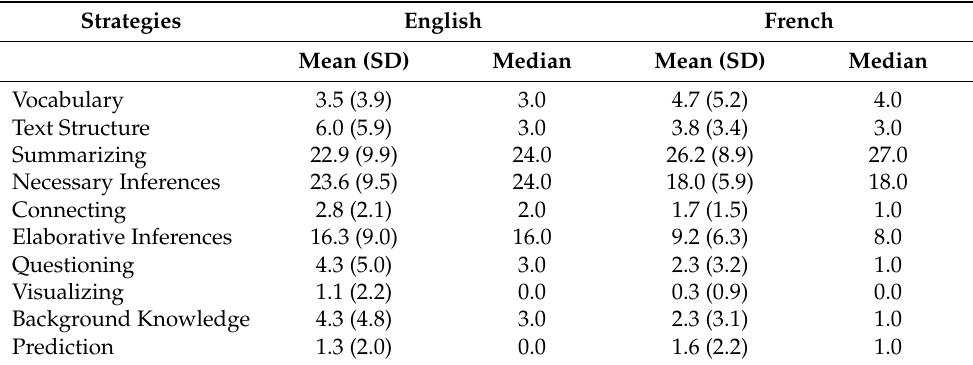
Table 2. Mean (with Standard Deviations) and Median Totals of Strategy Use as a Function of Text